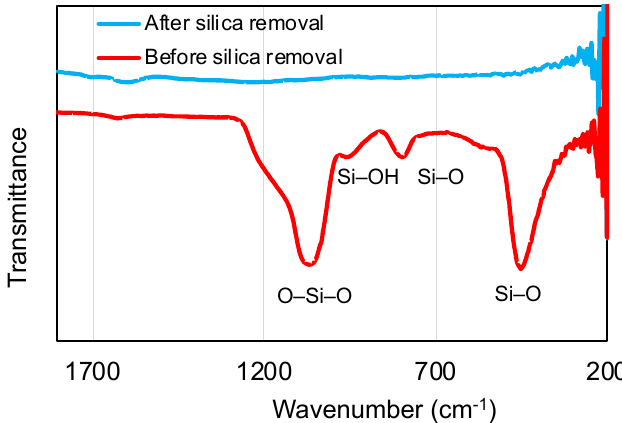
Figure 4. FTIR analysis showing the absence of silica after the etching process.